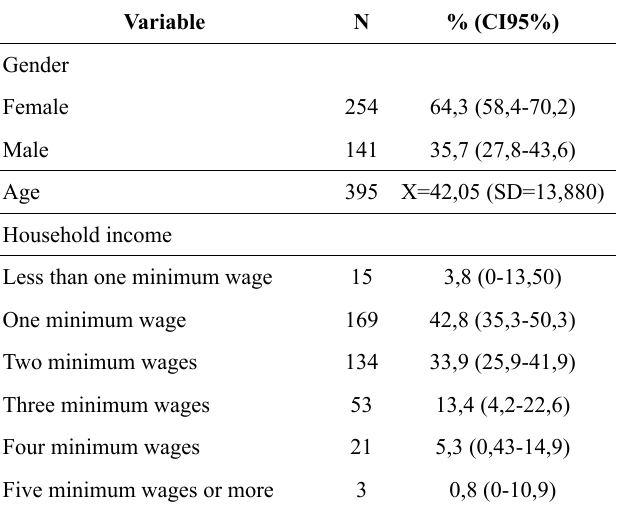
Table 1. Description of the variables analyzed from adults aged be - tween 18–65 years, living in the city of Uruguaiana (Brazil) near the Sports and Culture